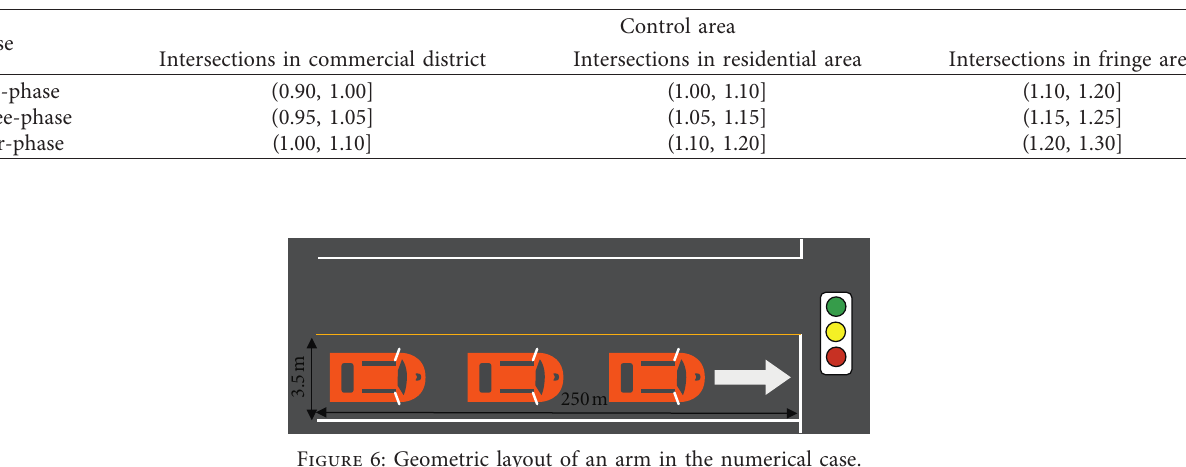
Table 4: Range of adjustment coefficient δ .